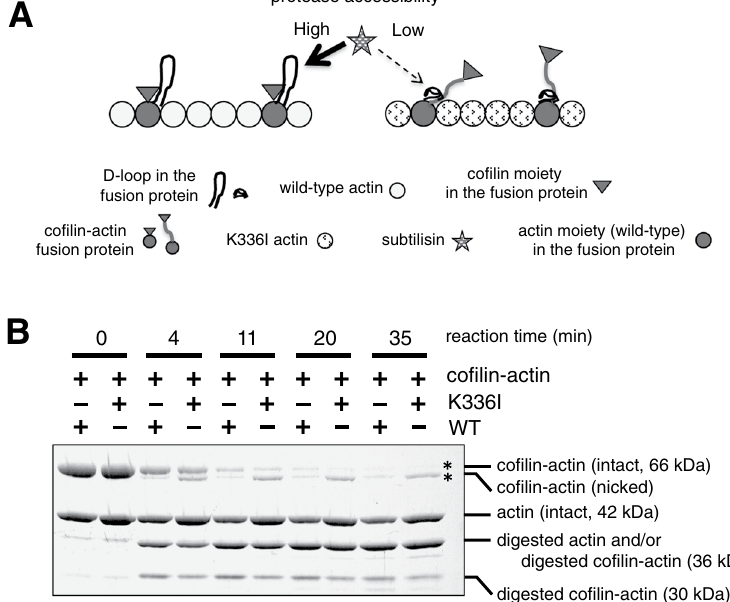
Figure 5. Copolymerisation of cofilin–actin fusion protein with K336I actin affects cleavage of the D-loop in the fusion protein. As shown in our previous report 31 , the fusion protein polymerises and depolymerises normally in a salt-dependent manner, and the cofilin moiety in the fusion protein has a pH-sensitive depolymerisation and severing activities of actin filaments. These functional properties of the cofilin moiety are similar to that of normal cofilin. Thus, there is seems to be no steric problem between the actin and cofilin moieties in the fusion protein in terms of interaction with other actin molecules. ( A ) Schematic drawing showing the detection of structural changes of the actin moiety in the fusion protein when copolymerised with K336I actin. In a co-filament, when K336I actin protomers affect the structure of the WT actin moiety of the fusion protein, they reduce the affinity of that actin moiety for cofilin moiety, causing its D-loop to have reduced susceptibility to subtilisin cleavage. The D-loop of actin (except for the actin moiety in the fusion protein) is not shown. ( B ) Subtilisin digestions of K336I/cofilin–actin co-filaments or WT/cofilin–actin co-filaments. Cofilin–actin fusion protein with an intact D-loop became slightly smaller after treatment with subtilisin, presumably due to nicking in the cofilin moiety by subtilisin, as shown in our previous report 31 . Digestion of the D-loop in the cofilin–actin fusion protein yielded bands of approximately 30 and 36 kDa, and did not yield a 42 kDa band 31 . The amount of undigested D-loop of the fusion protein (the sum of the 66 kDa band and the slightly smaller nicked band, marked by asterisks) in the K336I/cofilin–actin co-filaments was greater than in the WT/cofilin–actin co-filaments when digested for the same length of time. Nicking of the cofilin moiety in the fusion protein was accelerated by copolymerisation with K336I actin, and was most evident after 11 minutes of subtilisin digestion. This is consistent with the results of co-sedimentation experiments (Fig. 4), and supports the model shown in ( A ). Full-length gel image is shown in Supplementary Fig.